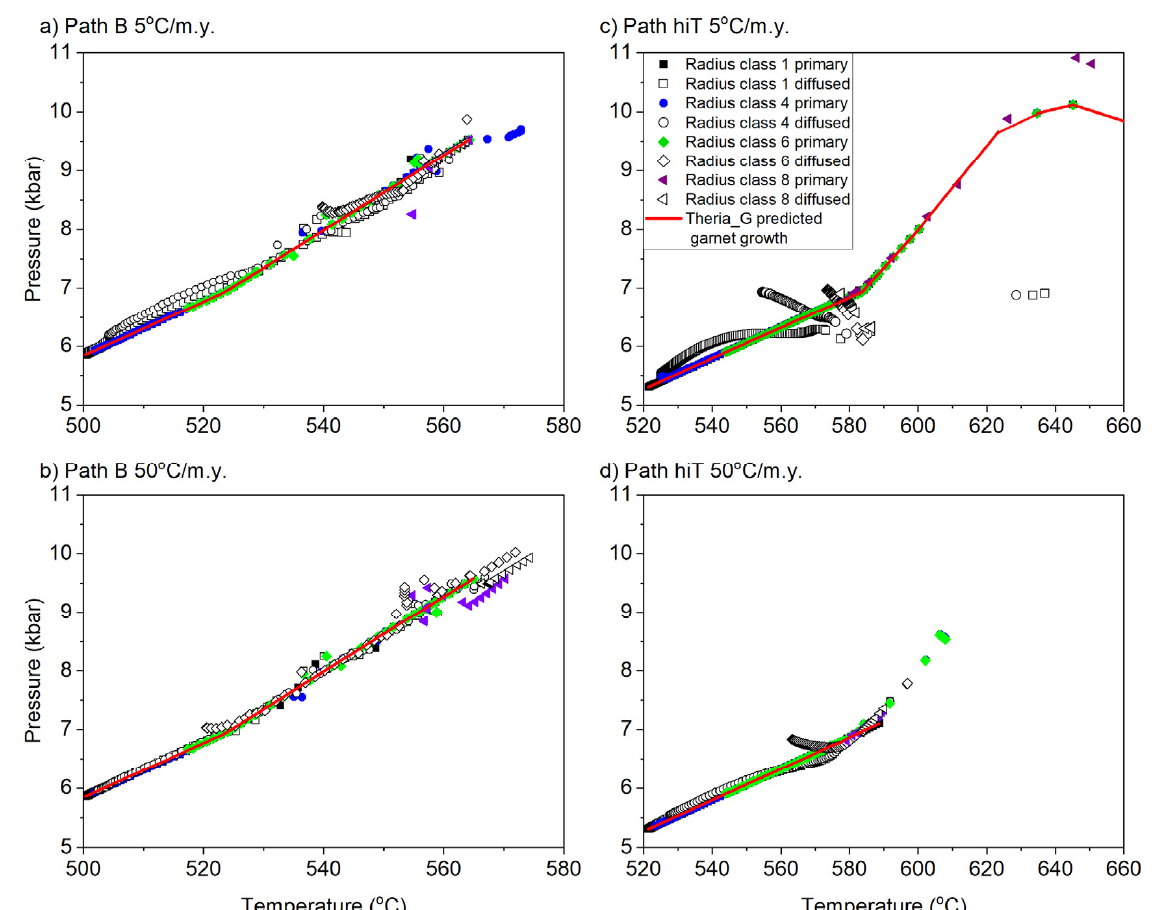
Figure 7. GZM modeled garnet P-T paths using Theria_G simulated garnet compositions (both primary and diffused) presented in Figure 3 as specified profiles. ( a ) P-T paths for radii classes 1, 4, 6, and 8 modeled by GZM using garnet compositions generated in simulation 1 (Path B, heating/cooling rate of 5 °C/my). ( b ) P-T paths for radii classes 1, 4, 6, and 8 modeled by GZM using garnet compositions generated in simulation 2 (Path B, heating/cooling rate of 50 °C/my). ( c ) P-T paths for radii classes 1, 4, 6, and 8 modeled by GZM using garnet compositions generated in simulation 3 (Path hiT, heating/cooling rate of 5 °C/my). ( d ) P-T paths for radii classes 1, 4, 6, and 8 modeled by GZM using garnet compositions generated in simulation 1 (Path hiT, heating/cooling rate of 50 °C/my).